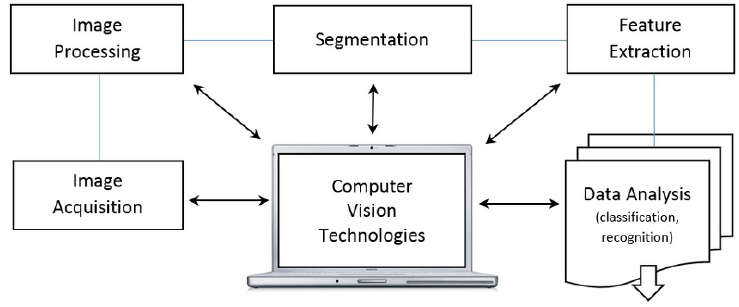
Fig. 1 Schematic diagram of computer vision